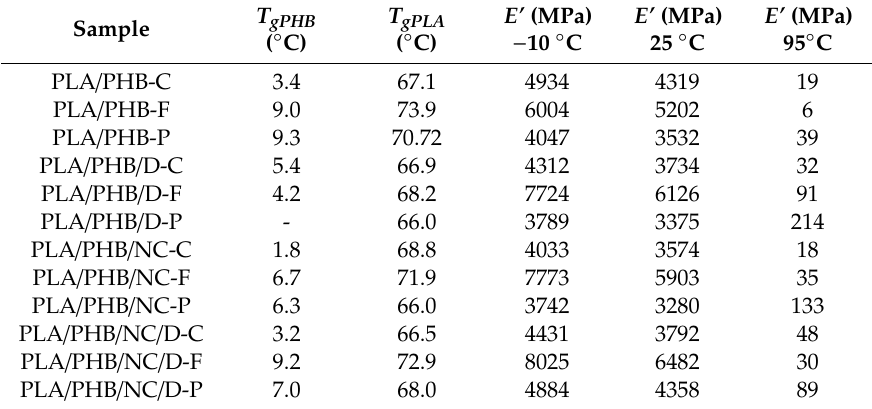
Table 4. Values of E’ in glassy and rubbery state and the glass transition temperature determined from tan δ curves ( T gPHB and T gPLA